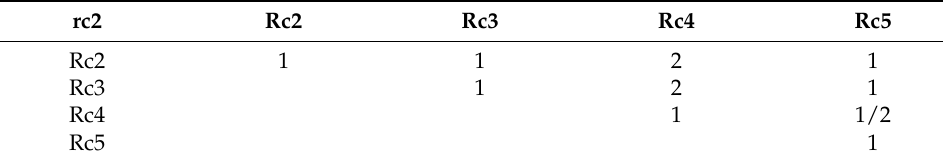
Table 5. Judgment matrix based on rc2 index.